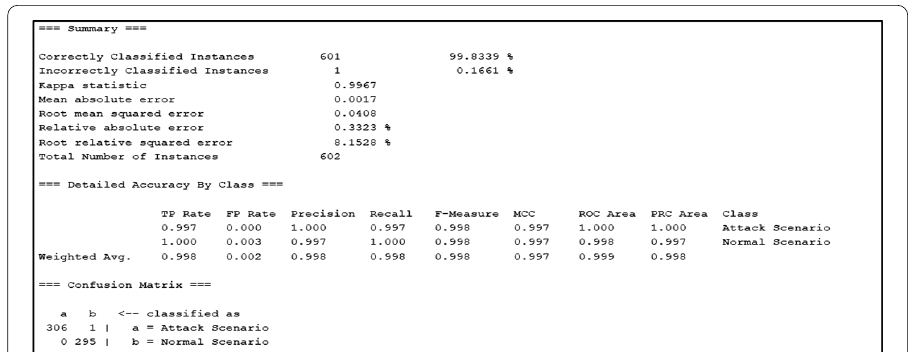
Fig. 5 Detailed Accuracy applying Cross Validation using Logistic Machine Learning Algorithm